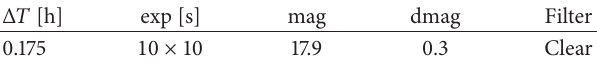
Figure 6: The optical light curve of GRB 080605 [12]; the dotted line is behaviour observed by Rumyantsev and Pozanenko [39] and Zafar et al. [38]. Table 8: GRB 090813: observing log of BOOTES-1B.